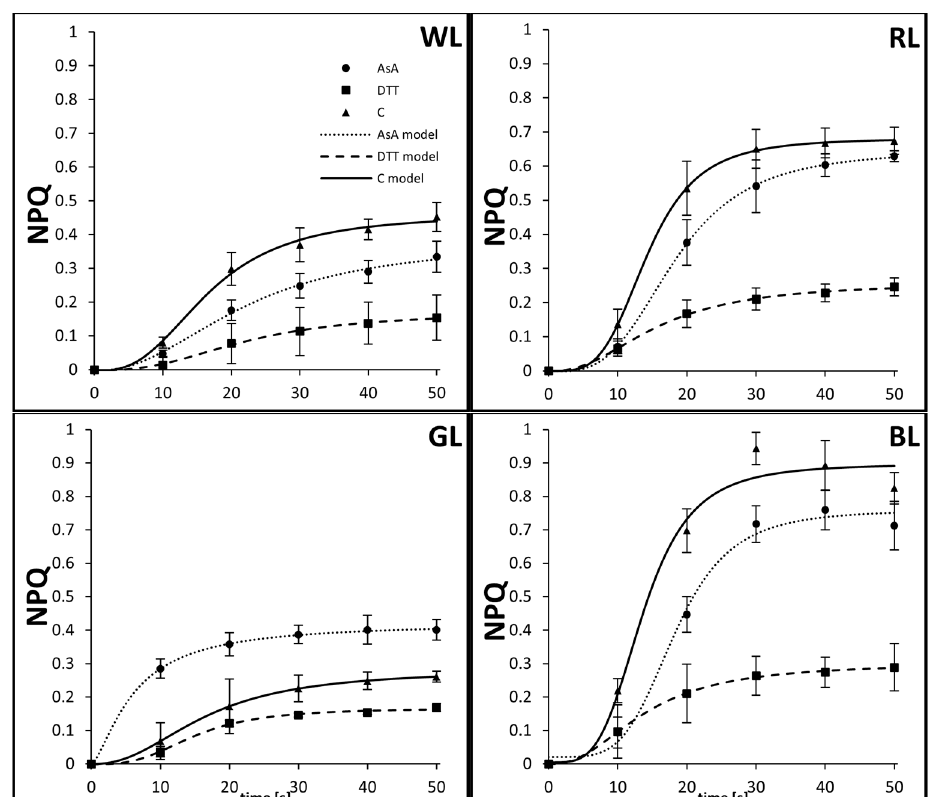
Figure 2. Dynamic changes of fast induction of non-photochemical quenching, NPQ, in leaves of tomato plants ( Solanum lycopersicum L. cv. Malinowy Ozarowski) grown under different LED light conditions (see Material and Methods for details). 10 mm diameter leaf discs were infiltrated with 10 mM ascorbic acid (AsA) or 5 mM dithiothreitol (DTT), or distilled water (C, control) for 30 min in the dark, followed by pre-illumination at 500 µmol m –2 s –1 of RGB light for next 30 min. The dynamics of the NPQ induction were determined in re-darkened leaf samples and derived from saturation pulses (5000 µmol m –2 s –1 , 0.8 s) applied every 10 s during the first 50 s of blue actinic light (AL = 450 nm) illumination. Each data point represents the average ± SD of six independent measurements ( n = 6). The logistic regression model was employed to fit the experimental data of fast (50 s) qE NPQ induc- tion in the AsA-, DTT- or water-treated samples. Fitting was applied as specified in Material and Methods and reported with an adjusted R 2 (R a2 ) value (Table 1) to determine the goodness of data fitting.